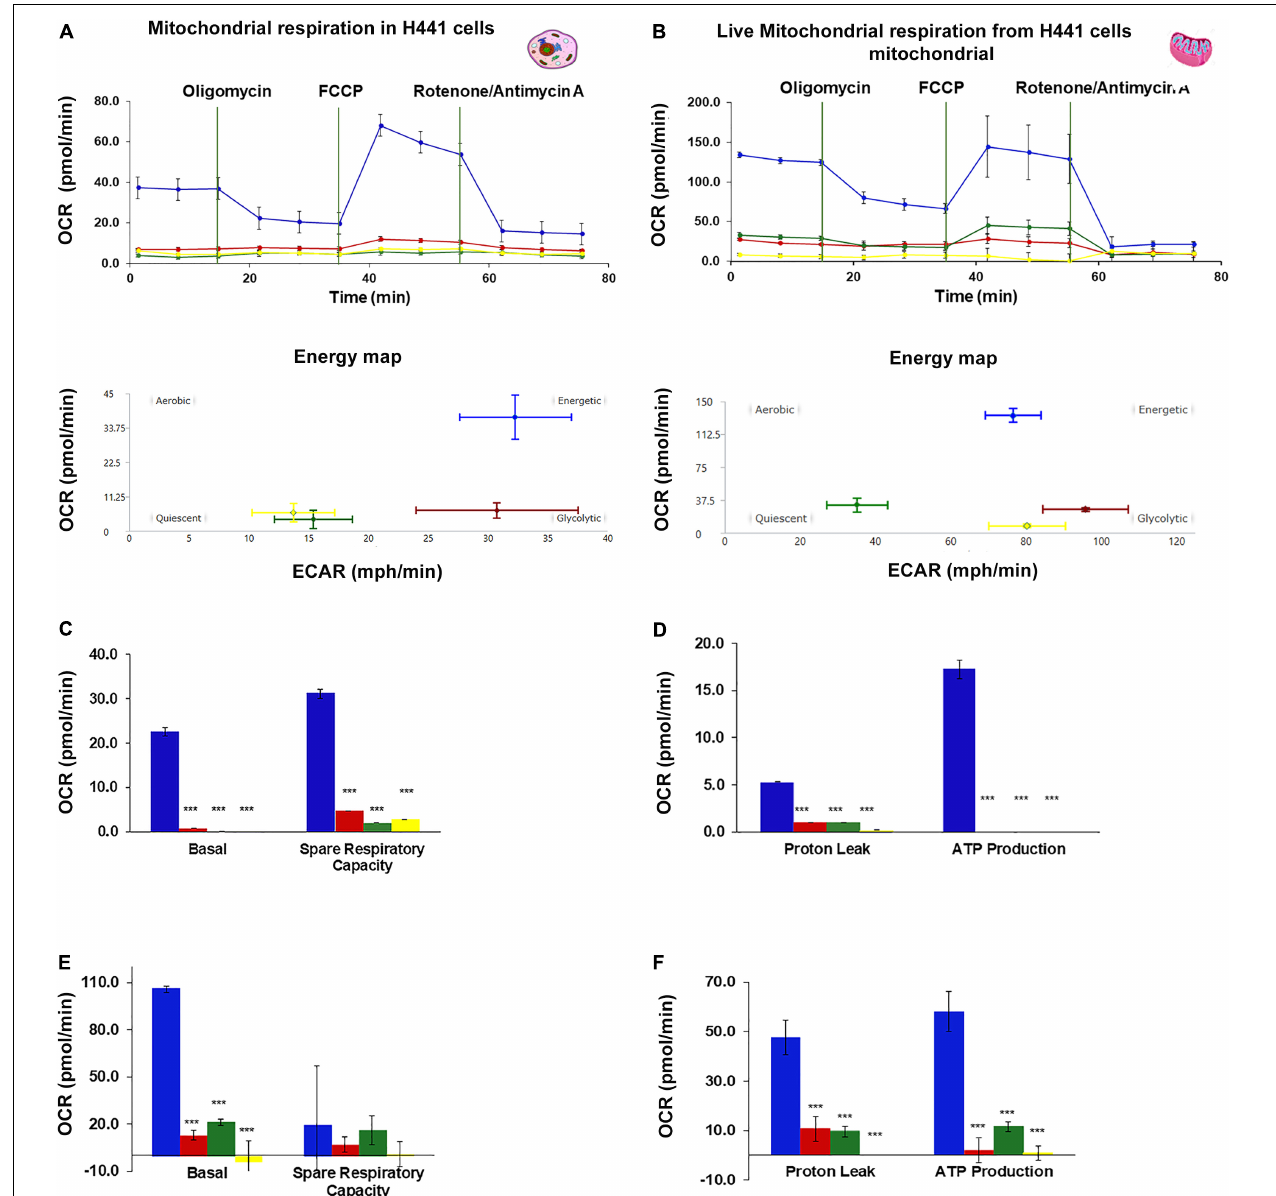
FIGURE 4 | Oxygen Consumption Rate (OCR) in H441 cells and live mitochondria-derived from H441 cells. (A,C,E) OCR in intact H441 cells, (A) mitochondrial respiration and energy map, (C) basal respiration and spare respiratory capacity, (E) proton leak and ATP production. H441 cells were seeded at a density of 5 × 10 4 cells per well of 96 wells Seahorse Agilent plate, 20 wells were analyzed for each treatment, graphs represent mean ± SEM, one-way ANOVA, *** p ≤ 0.001. (B,D,F) OCR in live mitochondria-derived from H441 cells, (B) mitochondrial respiration and energy map, (D) basal respiration and spare respiratory capacity, (F) proton leak and ATP production. A total of 1,000,000 particles (mitochondria) were seed in each well of 96 Seahorse Agilent plate, 8 wells were analyzed for treatment, graphs represent mean ± SEM, one-way ANOVA, *** p ≤